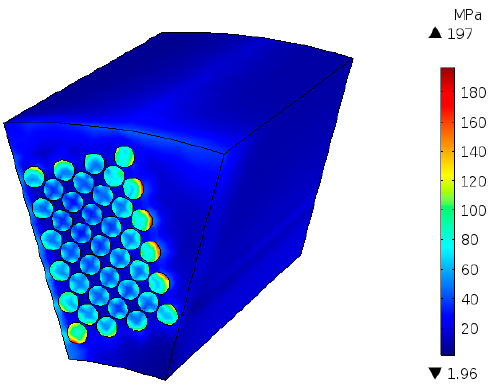
Figure 4. The von-Mises stress distribution in the winding (copper wires + epoxy).